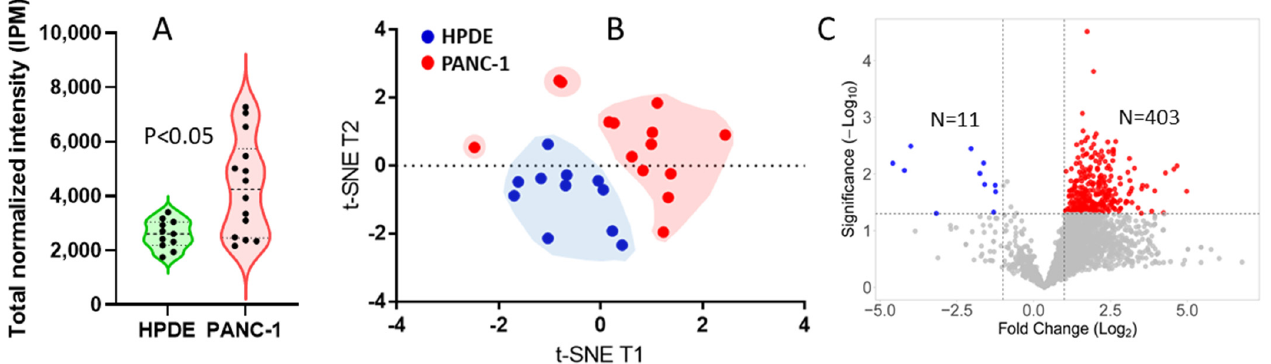
Figure 4. Single-cell analysis of HPDE and PANC-1 cells by SLB-SCP. ( A ) Comparison of total protein contents in the single cells of HPDE and PANC-1. ( B ) t-distributed stochastic neighbor-embedding (t-SNE) plot of the normal HPDE and cancerous PANC-1. While HPDE cells were aggregated, PANC-1 cells displayed 3 distinct subgroups. ( C ) Volcano plot of protein abundance ratio in comparison of PANC-1 with HPDE (PANC-1/HPDE).